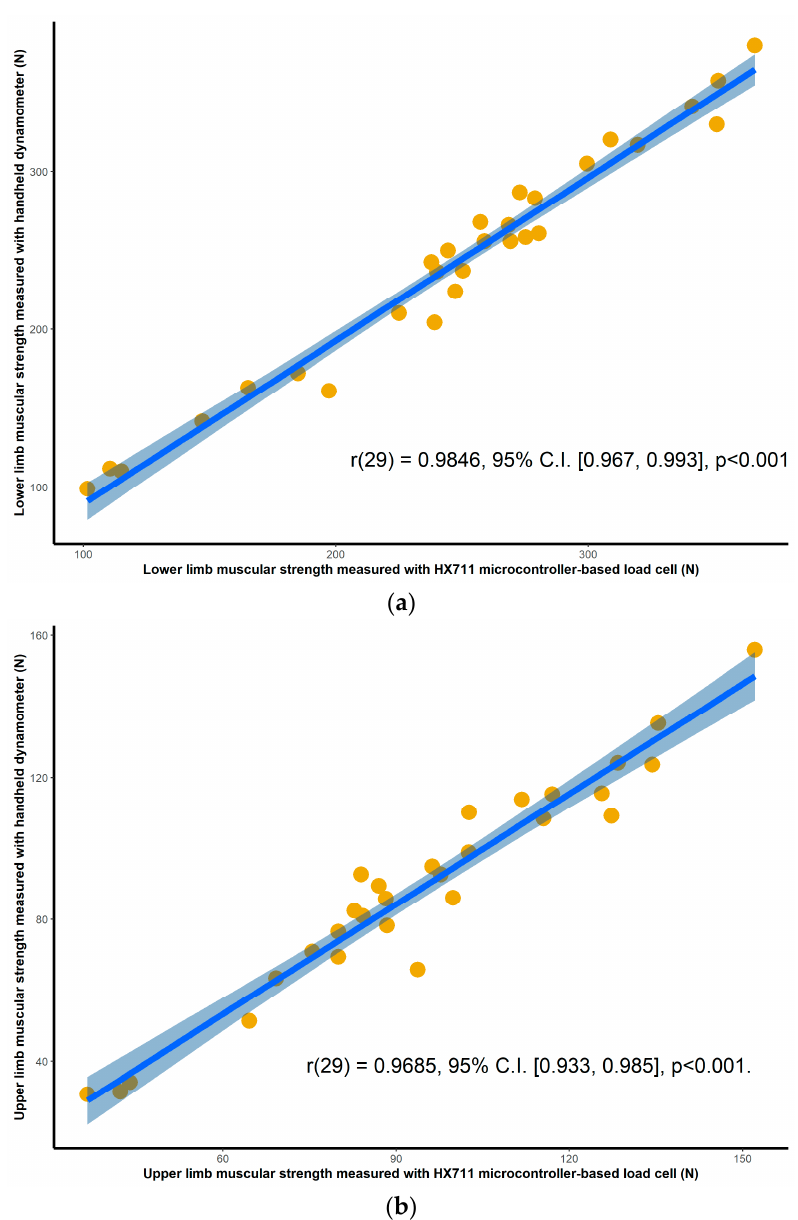
Figure 3. Session two correlations between the handheld dynamometer and the HX711 microcontroller-based load cell for: ( a ) maximal isometric leg extension; ( b ) maximal isometric bicep flexion. The blue line and the shaded area are the linear regression slope and its 95% confidence region.